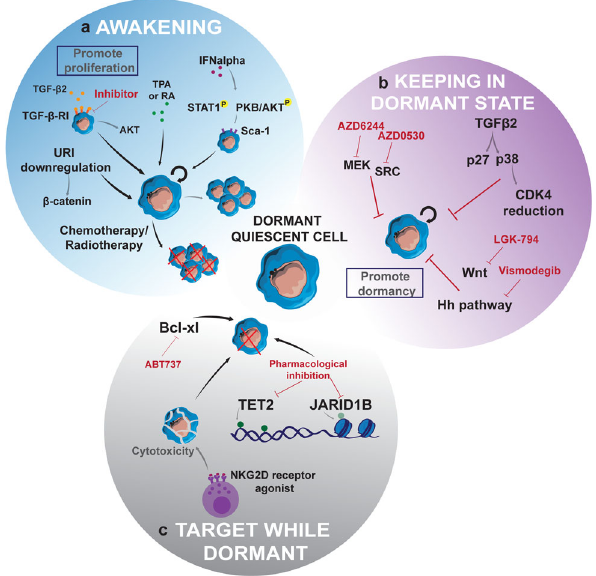
Fig. 2 Schematic representation of the different strategies to eradicate dormant quiescent cancer cells. Dormant quiescent or slow-cycling cells can mainly be targeted by three different strategies: a awakening, which aims to promote re-enter in cell cycle and proliferation of quiescent cells in order to be correctly targeted and eliminated by anti-proliferative therapies; b keeping the dormant state to avoid awakening and tumour relapse; and c targeting while dormant, which is based in targeting the crucial signalling pathways needed to keep cells in dormancy, such as epigenetic changes for